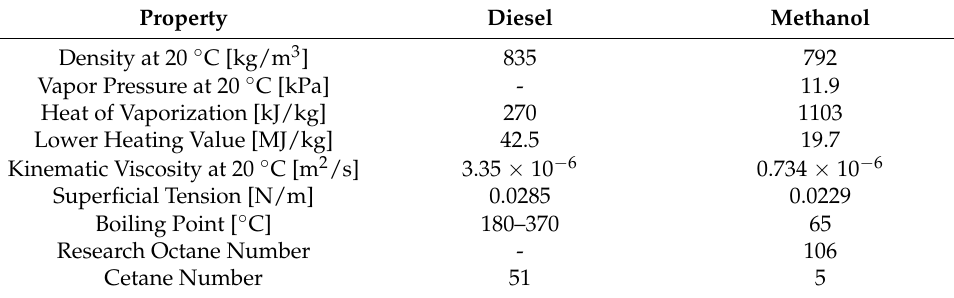
Table 1. Comparison of physicochemical properties [10,11]. Property